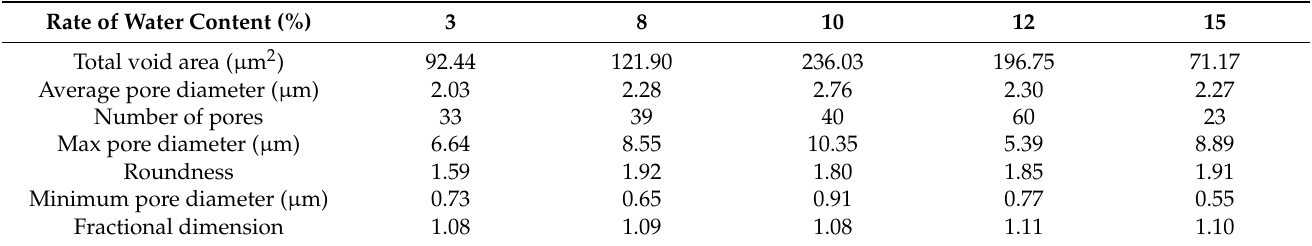
Table 3. Pore structure parameters of SN-1 mudstone samples.